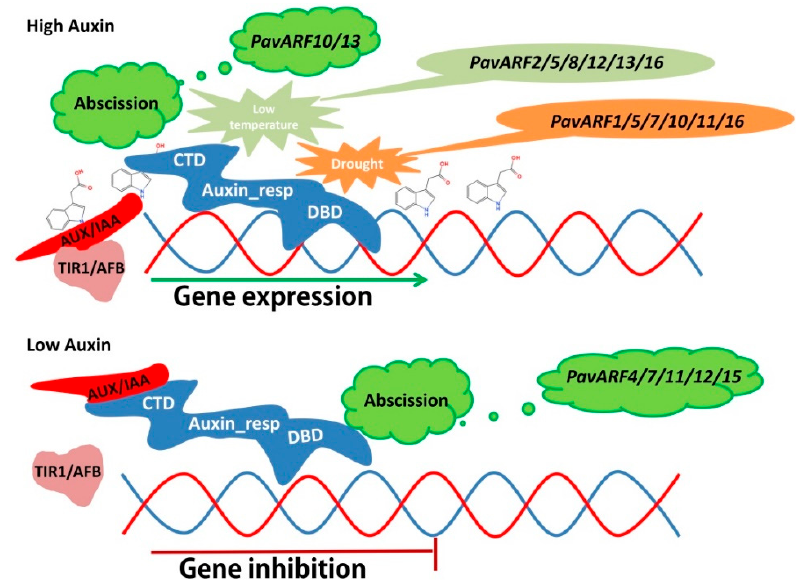
Figure 8. The expression patterns of sweet cherry ARF gene family members during fruit shedding, drought and low temperature stress. Under drought, low temperature and shedding, PavARF binds to AuxRE elements under the action of auxin to initiate gene expression. For other genes, when the auxin is low, PavARF binds to AUX/IAA, and the gene expression is inhibited.